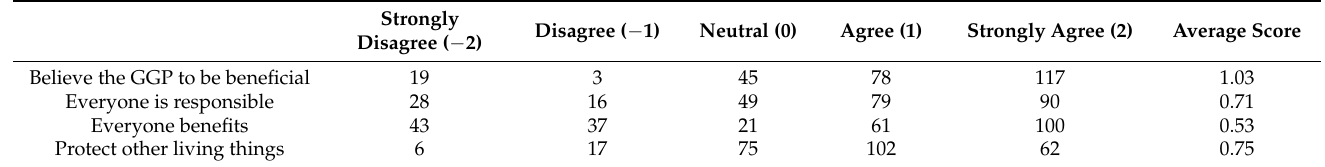
Table 3. Farmers’ awareness of ecology and environmental protection.